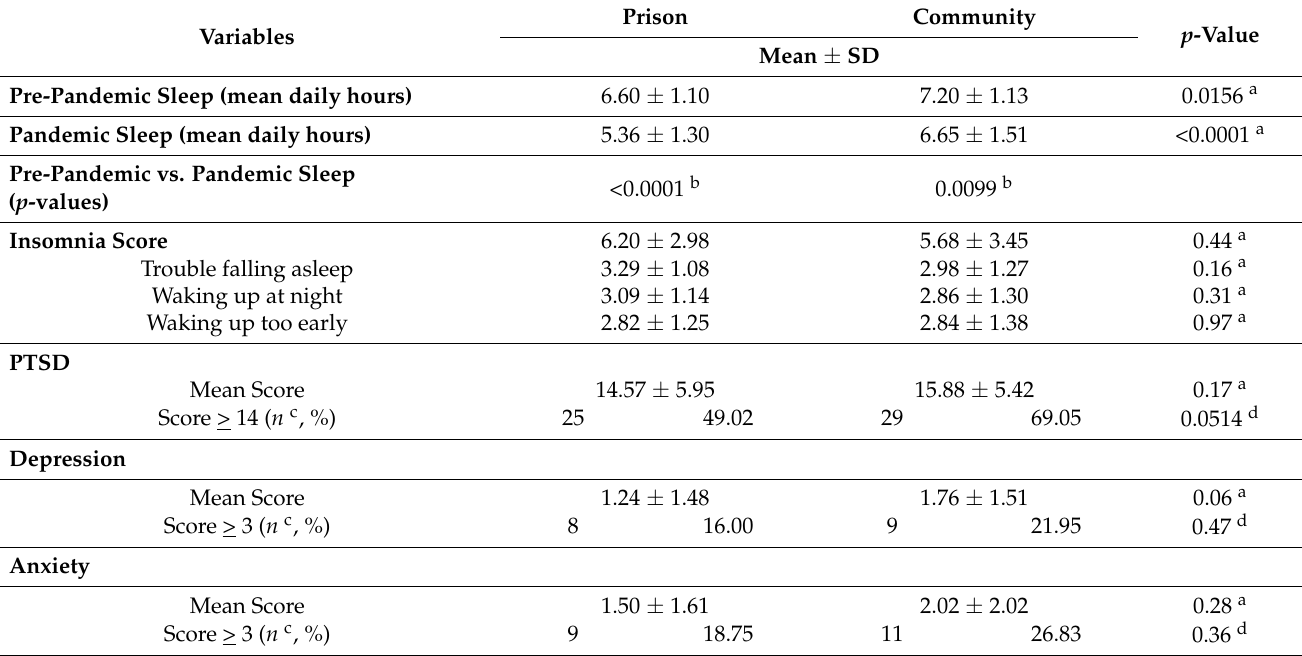
Table 4. Sleep and psychological